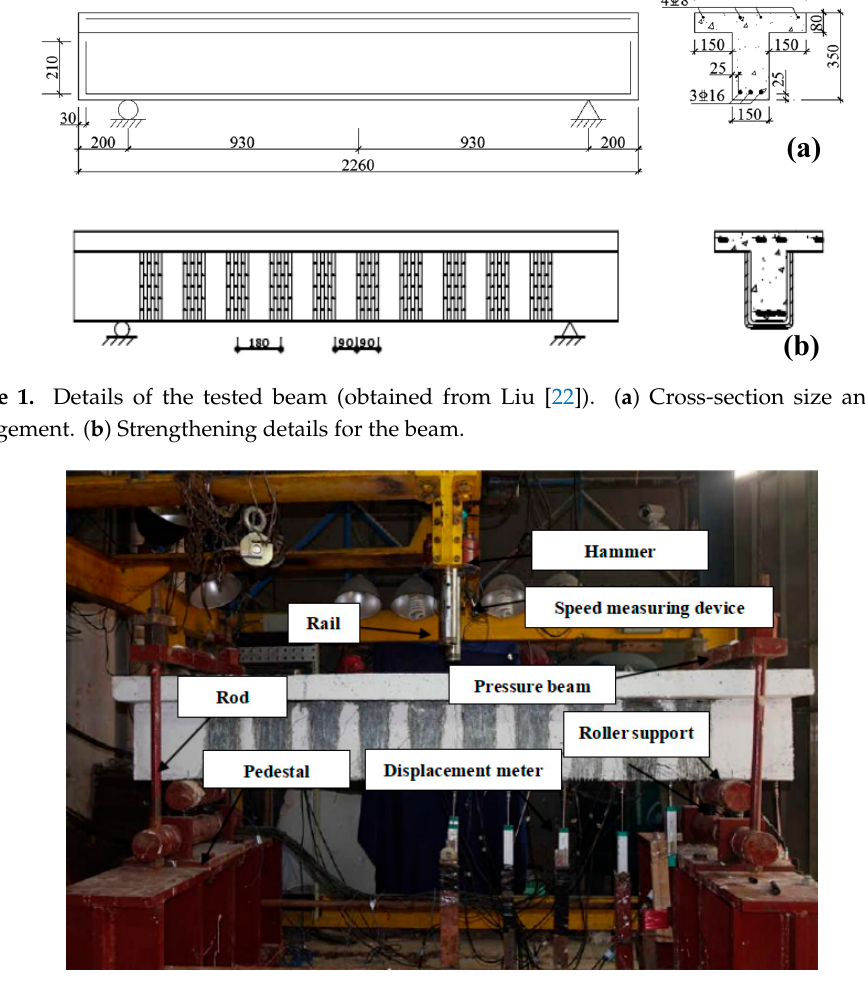
Figure 2. Drop hammer impact test setup (obtained from Liu [22]).